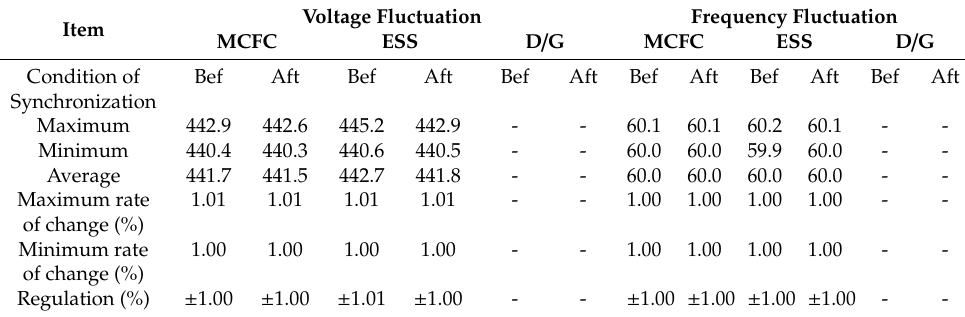
Table 15. Power data analysis before and after ESS synchronization.